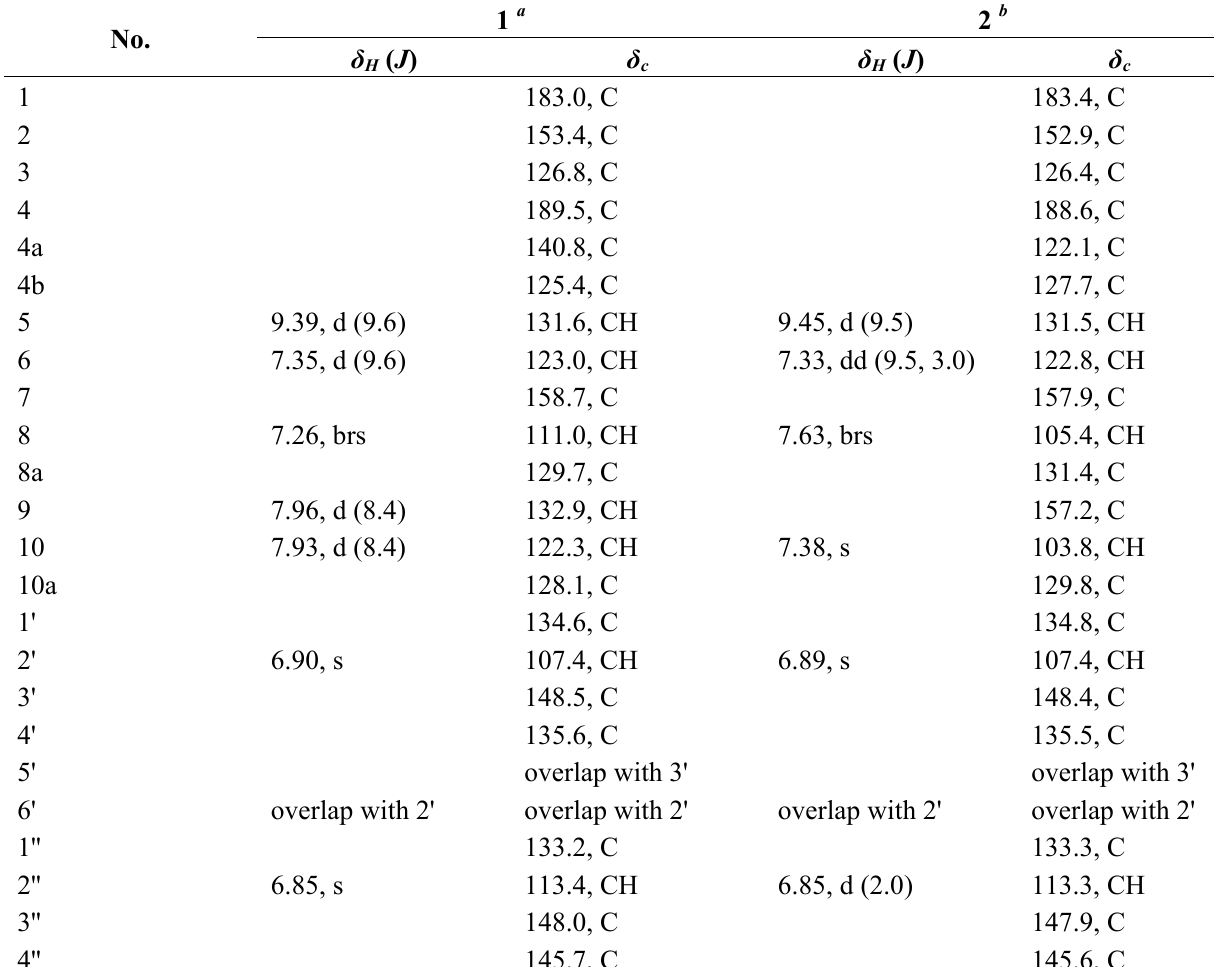
Table 1. NMR data for compounds 1 – 2